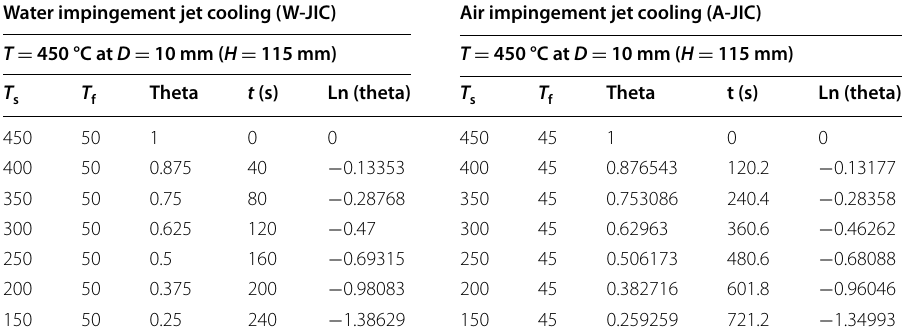
Table 6 Ln (theta) temperature time, D Water impingement jet cooling (W-JIC)